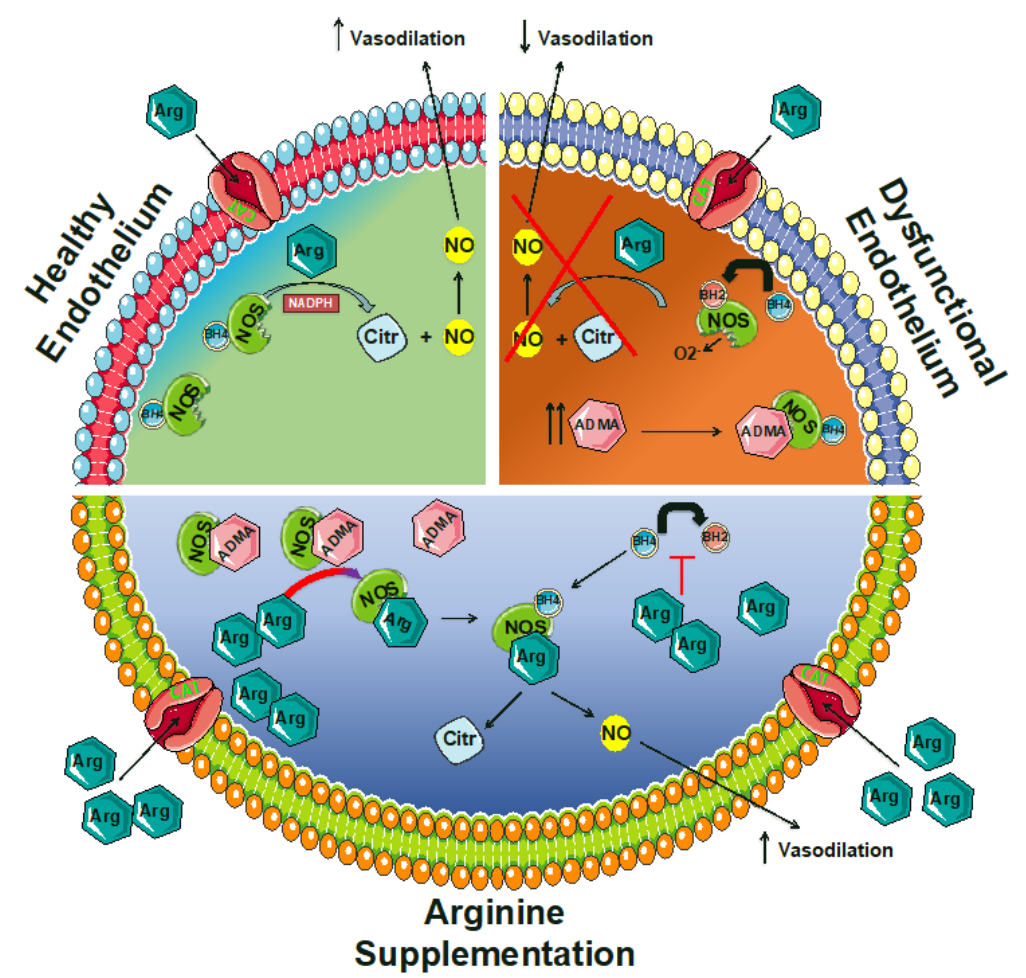
Figure2. Functional role of arginine in endothelial(dys)function. ADMA: asymmetric dimethylarginine; Arg: arginine; BH2: 7,8-dihydrobiopterin; BH4: tetrahydrobiopterin; CAT: cationic amino acid transporter; Citr: citrulline; NADPH: nicotinamide adenine dinucleotide phosphate; NO: nitric oxide; NOS: NO